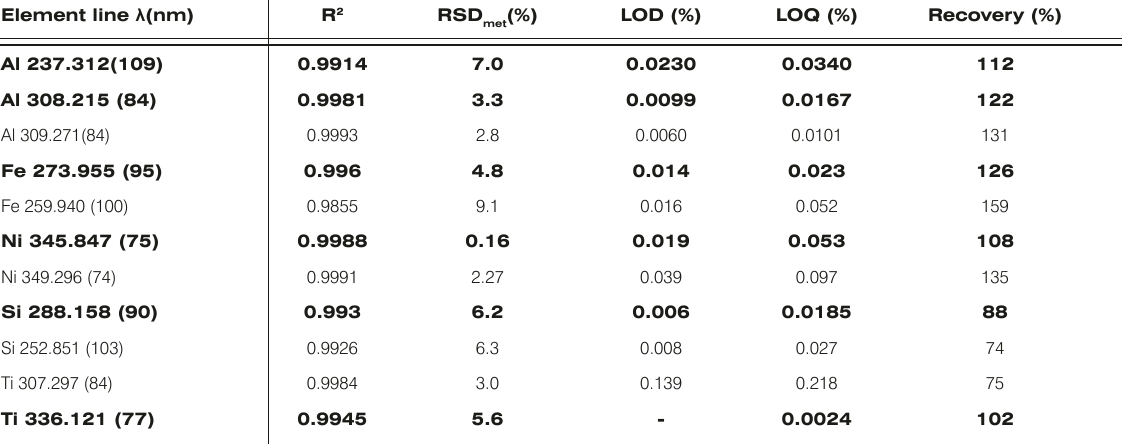
(Fig. 3) and validation parameters (Table 3) are presented only for final (total) - 3 rd calibration range: -All studied trace elements were calibrated in concentration region 1.0-0.0003%.